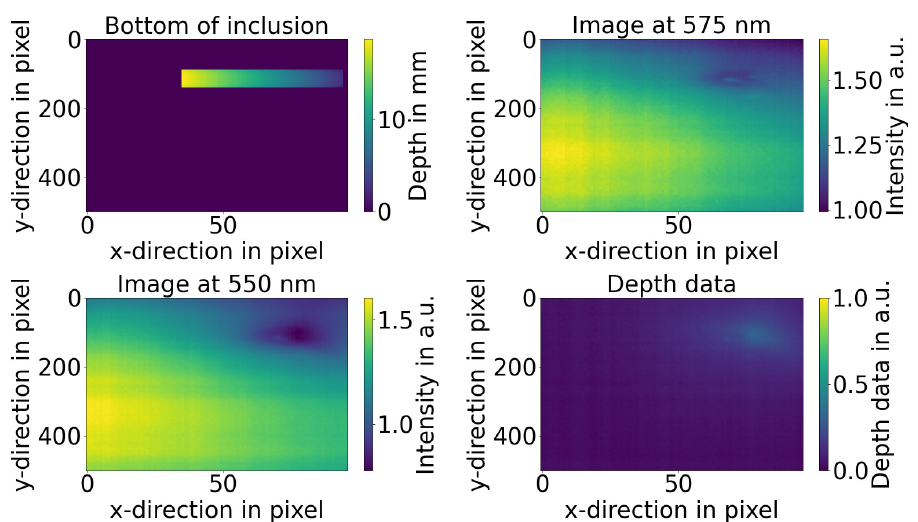
Figure 3. Comparison of the inclusion measured by OCT and caliper ( top left ) with the hyper-spectral signal at 550 nm ( bottom left ) and the hyper-spectral signal at the iso-point at 575 nm ( top right ) with the depth map ( bottom right ).